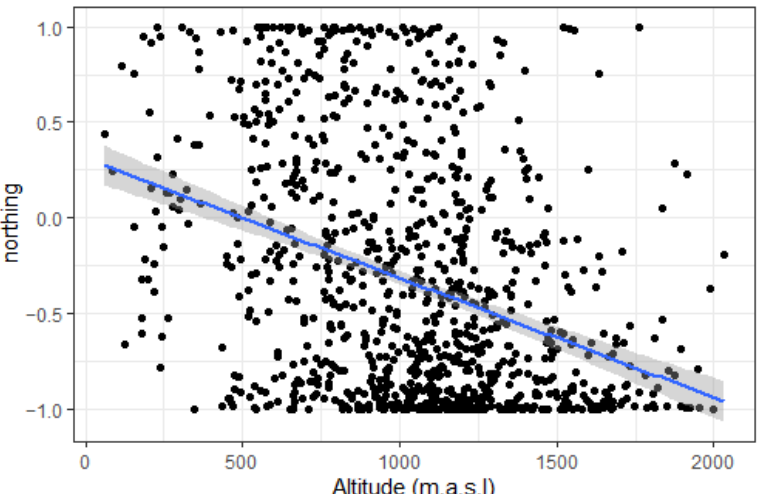
Figure 3. Linear relationship between northing and altitude for all known French locations of Lilium pomponium (black dots). The blue line corresponds to the linear regression ( p -value < 0.001, adjusted-R 2 = 0.126) and the grey band is the confidence interval at the 0.95 level.